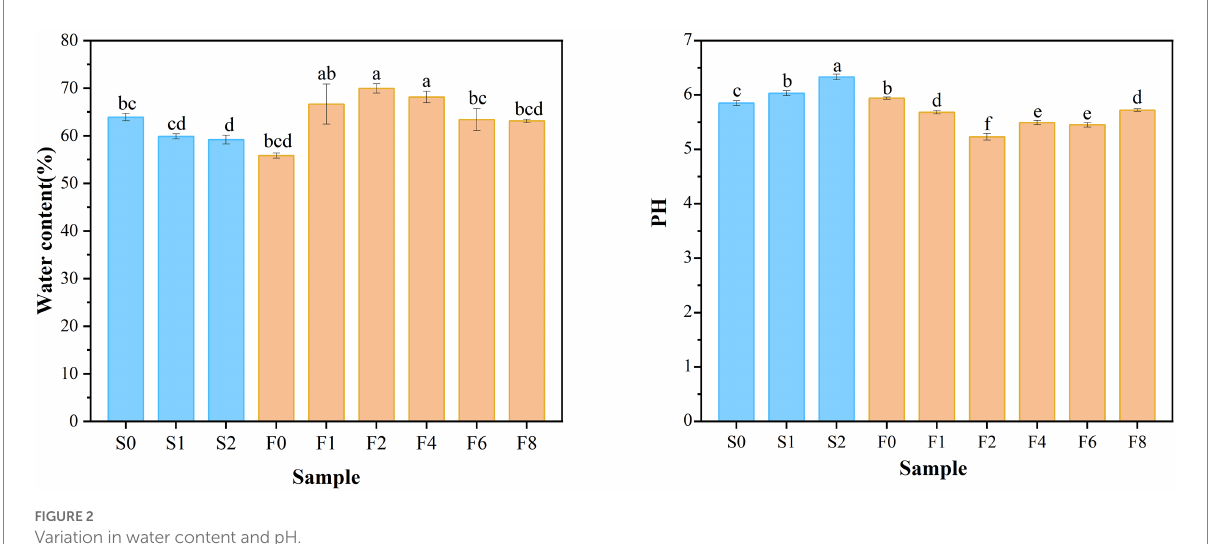
FIGURE 2 Variation in water content and pH.